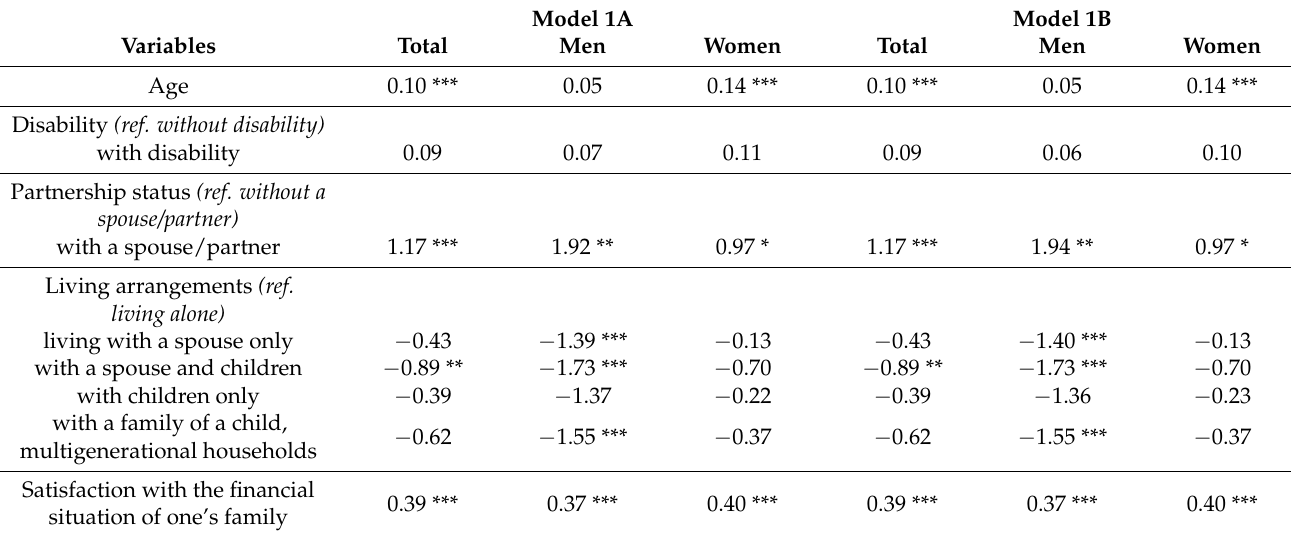
Table 1. Results of the fixed-effects ordered logit models predicting the happiness levels among people aged 55–69 who retired in